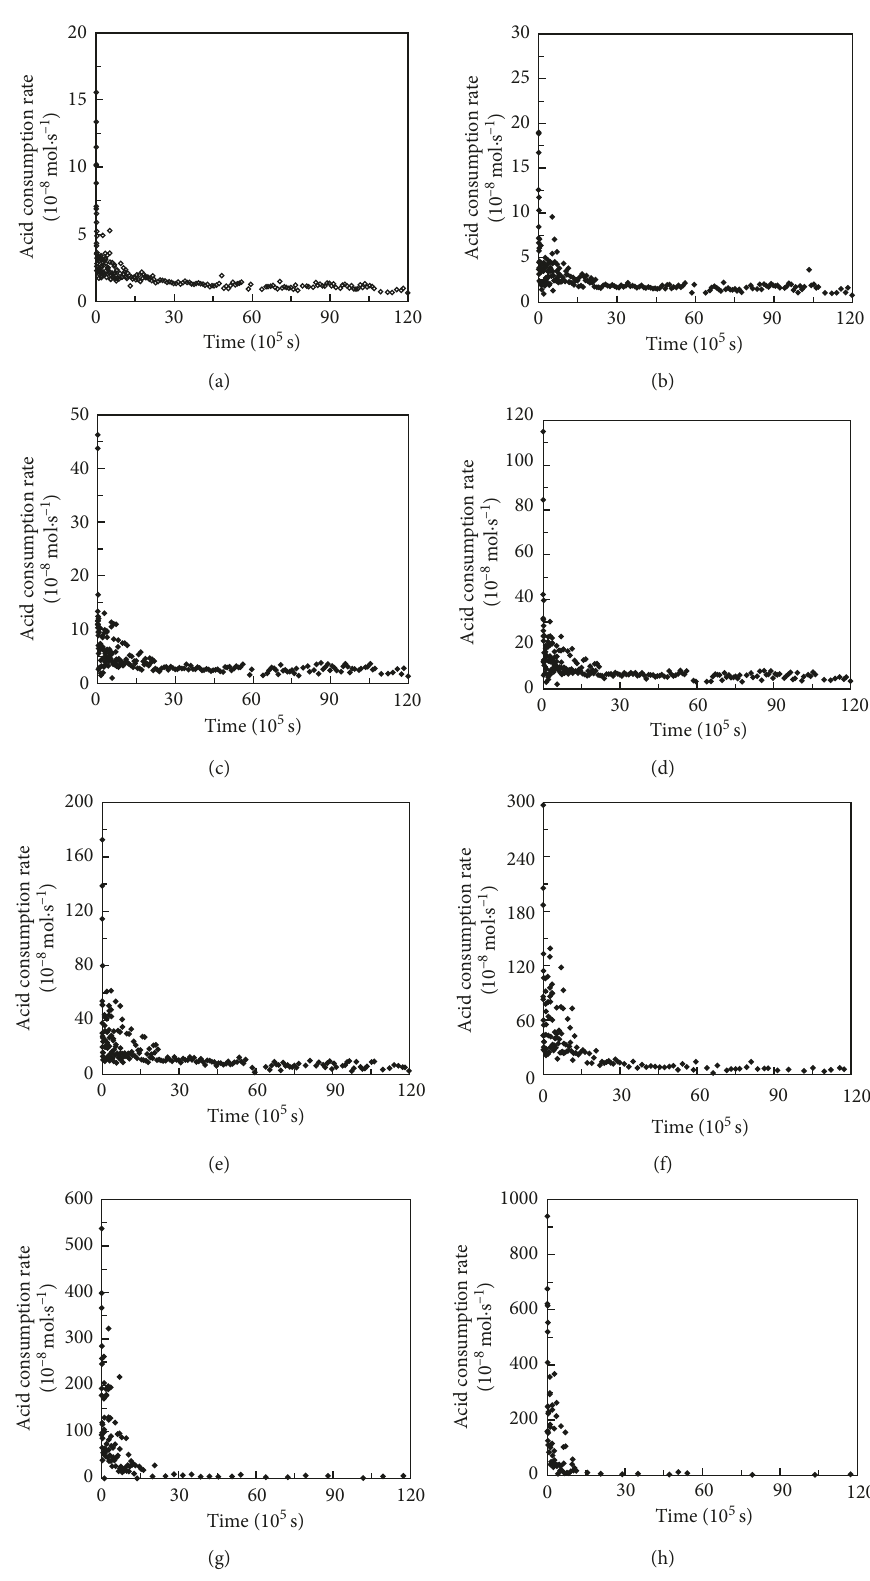
Figure 5: Relationship between the acid consumption rate and time. (a) pH � 4.00, w / c � 0.40. (b) pH � 3.70, w / c � 0.50. (c) pH � 3.40, w / c � 0.60. (d) pH � 3.10, w / c � 0.70. (e) pH � 2.80, w / c � 0.35. (f) pH � 2.50, w / c � 0.45. (g) pH � 2.20, w / c � 0.55. (h) pH � 2.00, w / c �